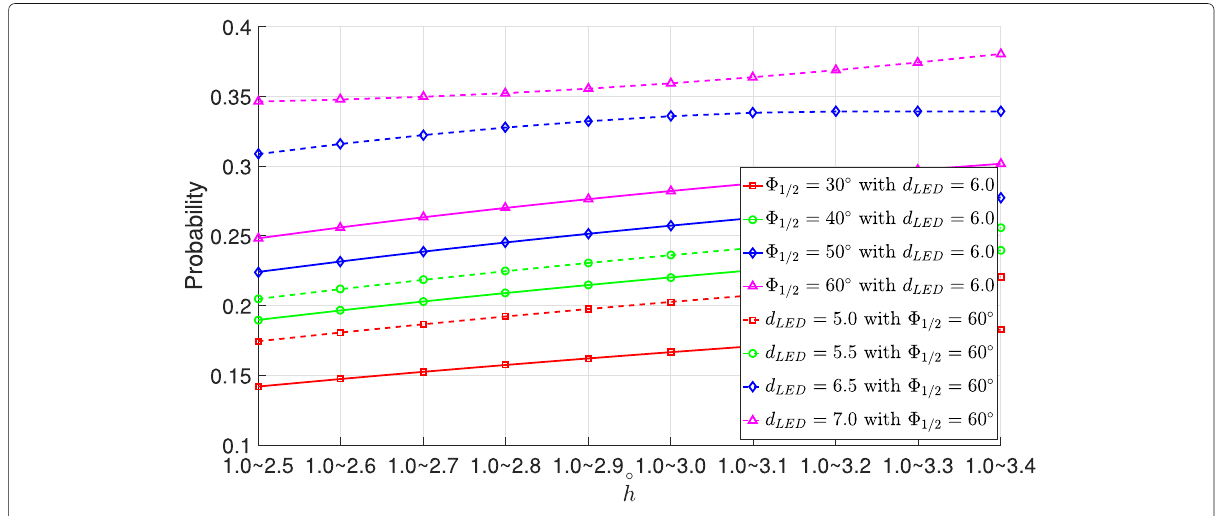
Fig. 10 Probability of the ratio between channel gains with different (cid:5) 1 / 2 and d